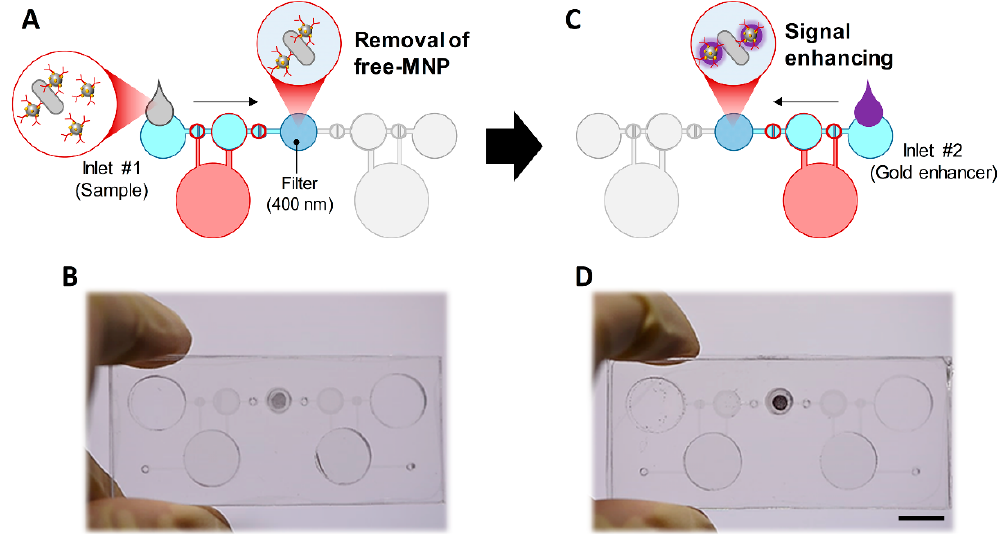
Figure 2. Procedures for the device operation. (A,B) Unbound free MNPs were washed out and MNP- bound E. coli O157:H7 generates a colorimetric signal on a filter membrane. (C,D) The colorimetric = 1 signal was amplified by injecting a gold enhancer solution. Scale bar = 1 cm. signal was amplified by injecting a gold enhancer solution. Scale bar